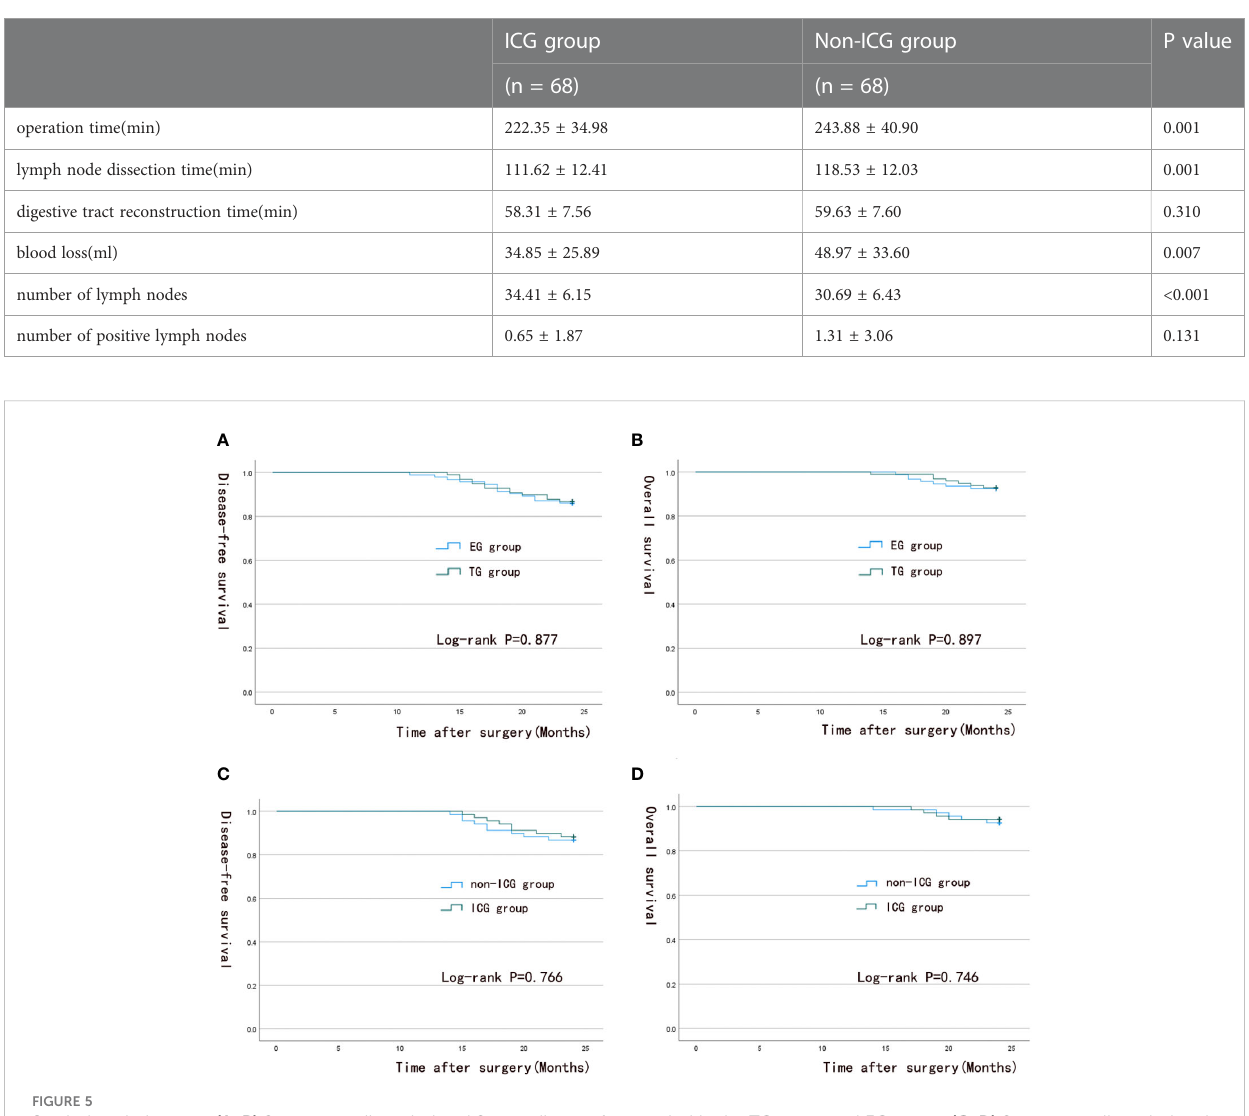
TABLE 8 ICG analysis(After propensity